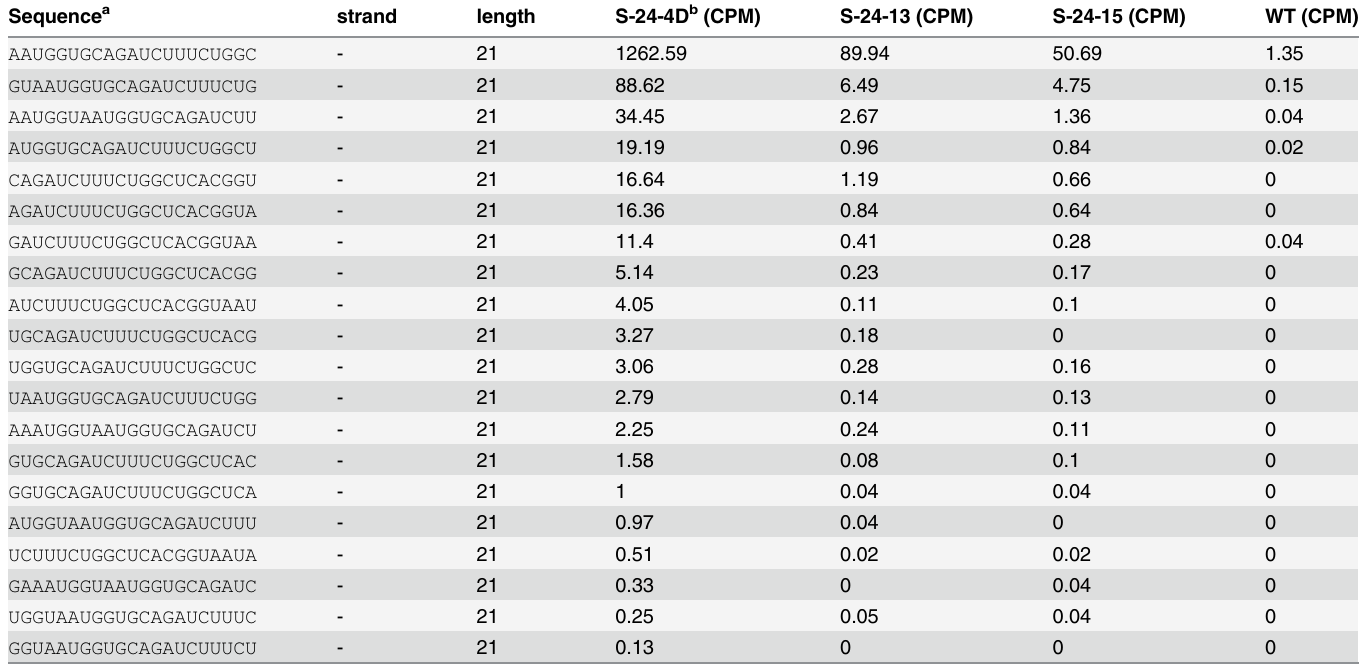
Table 1. Putative functional